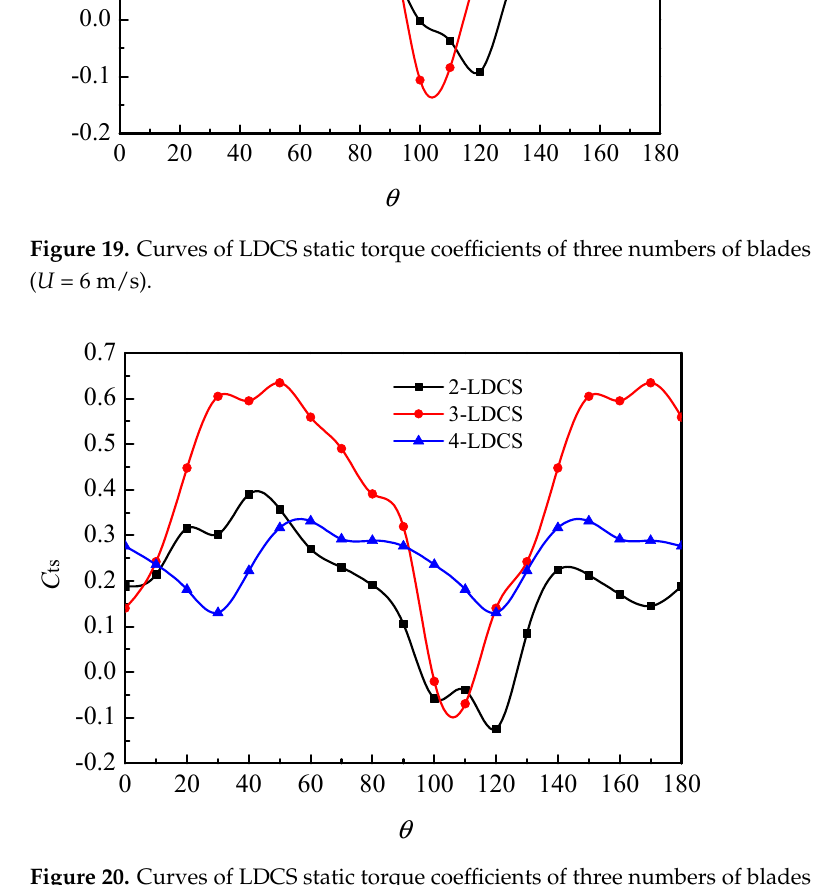
Figure 21. The change in the average increase in the static torque of the three numbers of blades LDCS. As shown in Figure 19, the C ts of the three numbers of blades LDCS in one rotation period has extremely different distribution rules when U = 6 m/s. Among them, the C ts of three-bladed LDCS showed a trend of a single high peak and low valley, and the value was higher. The peak at θ = 30° reached around 0.45. The C ts of two-bladed LDCS showed a double peak and single valley trend with a wide varied range. The C ts of four-bladed LDCS showed a single peak and single valley change. The four-bladed LDCS had lower C ts than the two-bladed LDCS. The difference between peak and valley values was small. The C ts peak of two-bladed LDCS can reach 0.25 at θ = 30°, and the C ts peak of four-bladed LDCS can reach 0.22 at θ = 60°. It can be observed that the C ts of LDCS with two-bladed LDCS and three-bladed LDCS were much smaller than the C ts value of three-bladed LDCS with 0.45. One week’s average solution of the C ts of three numbers of LDCS can be ob- tained, with two-blade of 0.13, three-blade of 0.22, and four-blade of 0.19. The average C ts of three-bladed LDCS was also found to be the highest. Therefore, the static starting char- acteristics of three-bladed LDCS are best at lower wind speeds. However, the lowest value of C ts of three-bladed LDCS was -0.15 in the range of 100°– 110°, which indicates that a starting negative torque region for three-bladed LDCS existed, which was smaller than the starting negative torque region of two-bladed LDCS 100°–